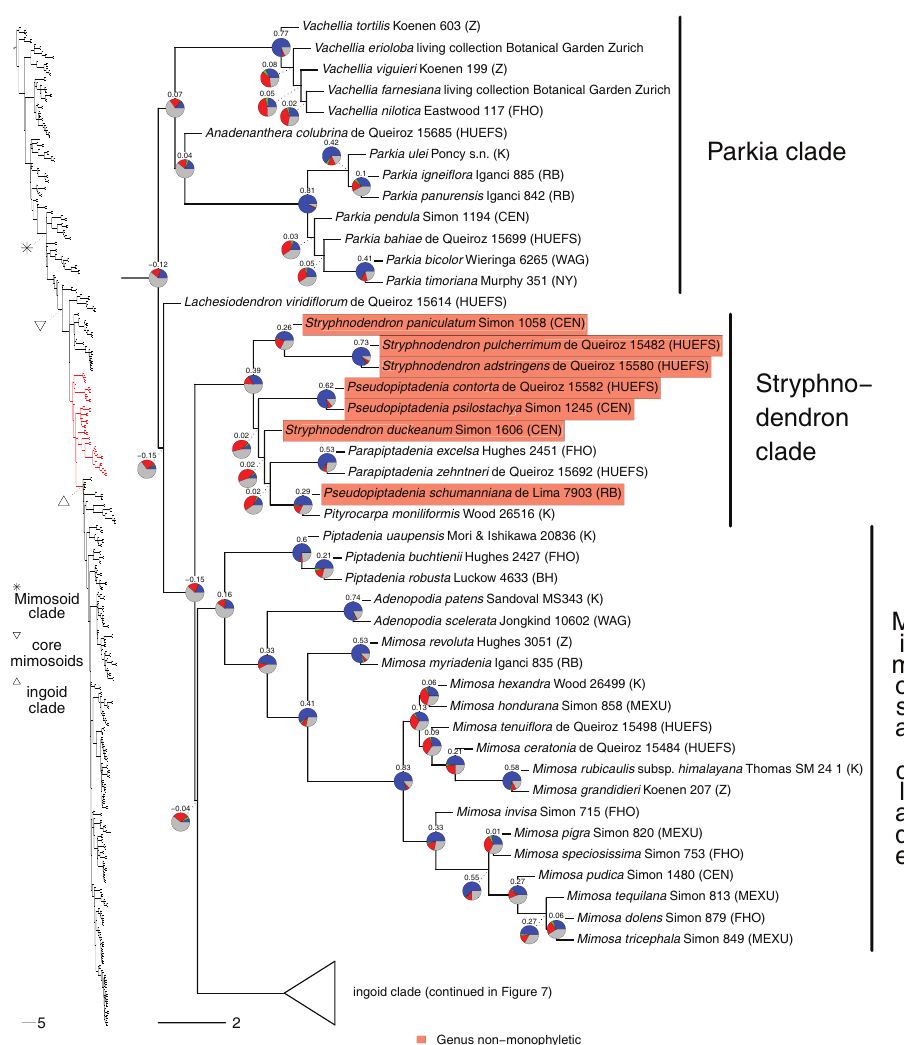
Figure 6. Phylogeny of Caesalpinioideae (continued). See Fig. 2 for